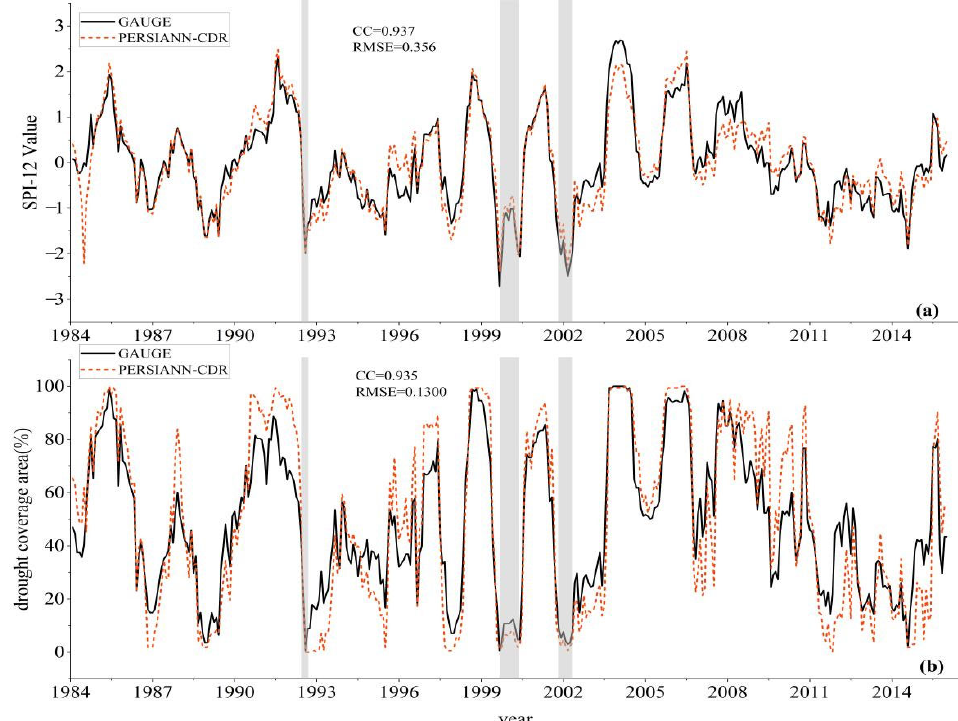
Figure 10. Comparison of ( a ) basin-average time series of SPI-12 and ( b ) drought area percentage time series of SPI-12 between basin-scale satellite estimation and gauge observations. The three grey columns highlighted represent three typical drought events selected based on SPI-12.